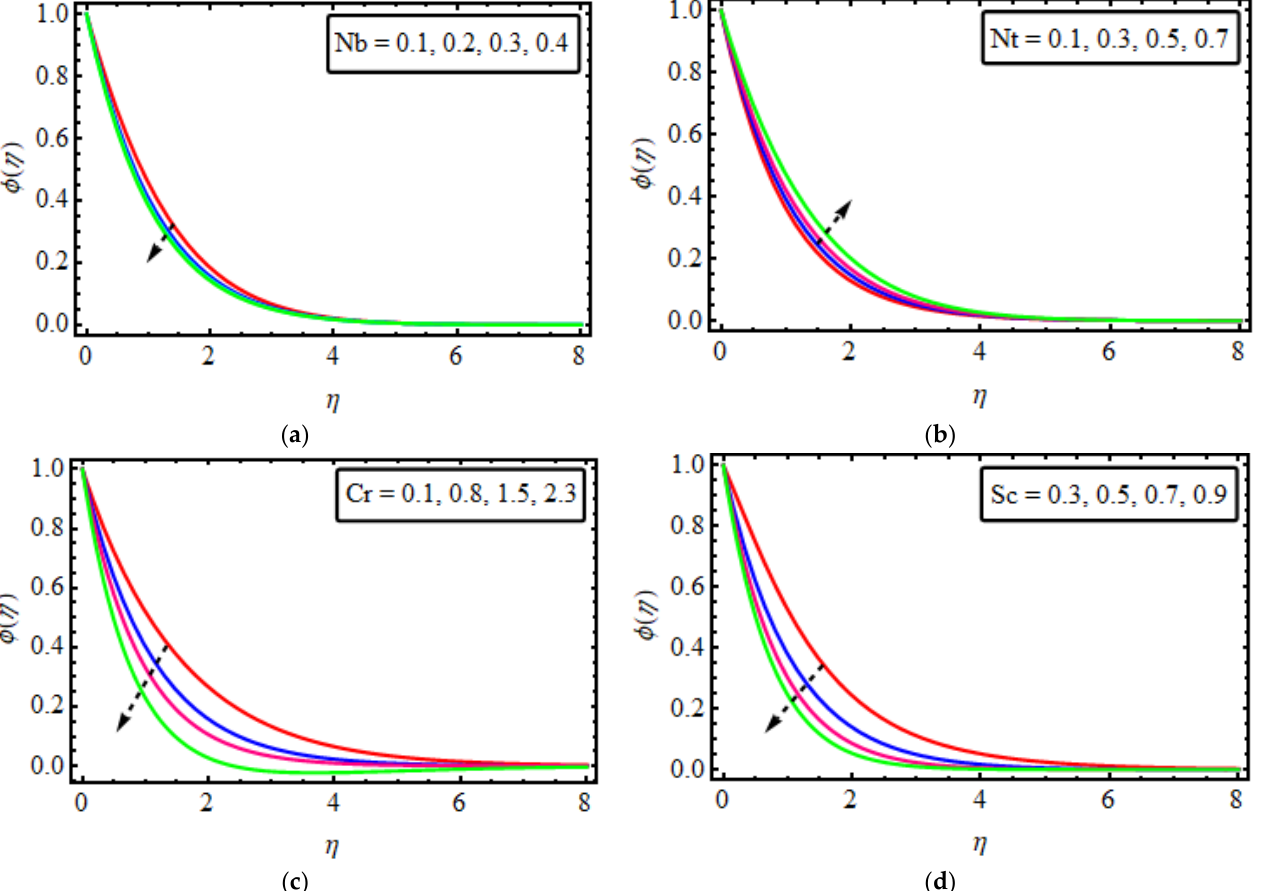
Figure 5. ( a – d ) The impact of φ ( η ) numerous variables ( a ) Nb ( b ) Nb ( c ) Cr ( d ) Sc .